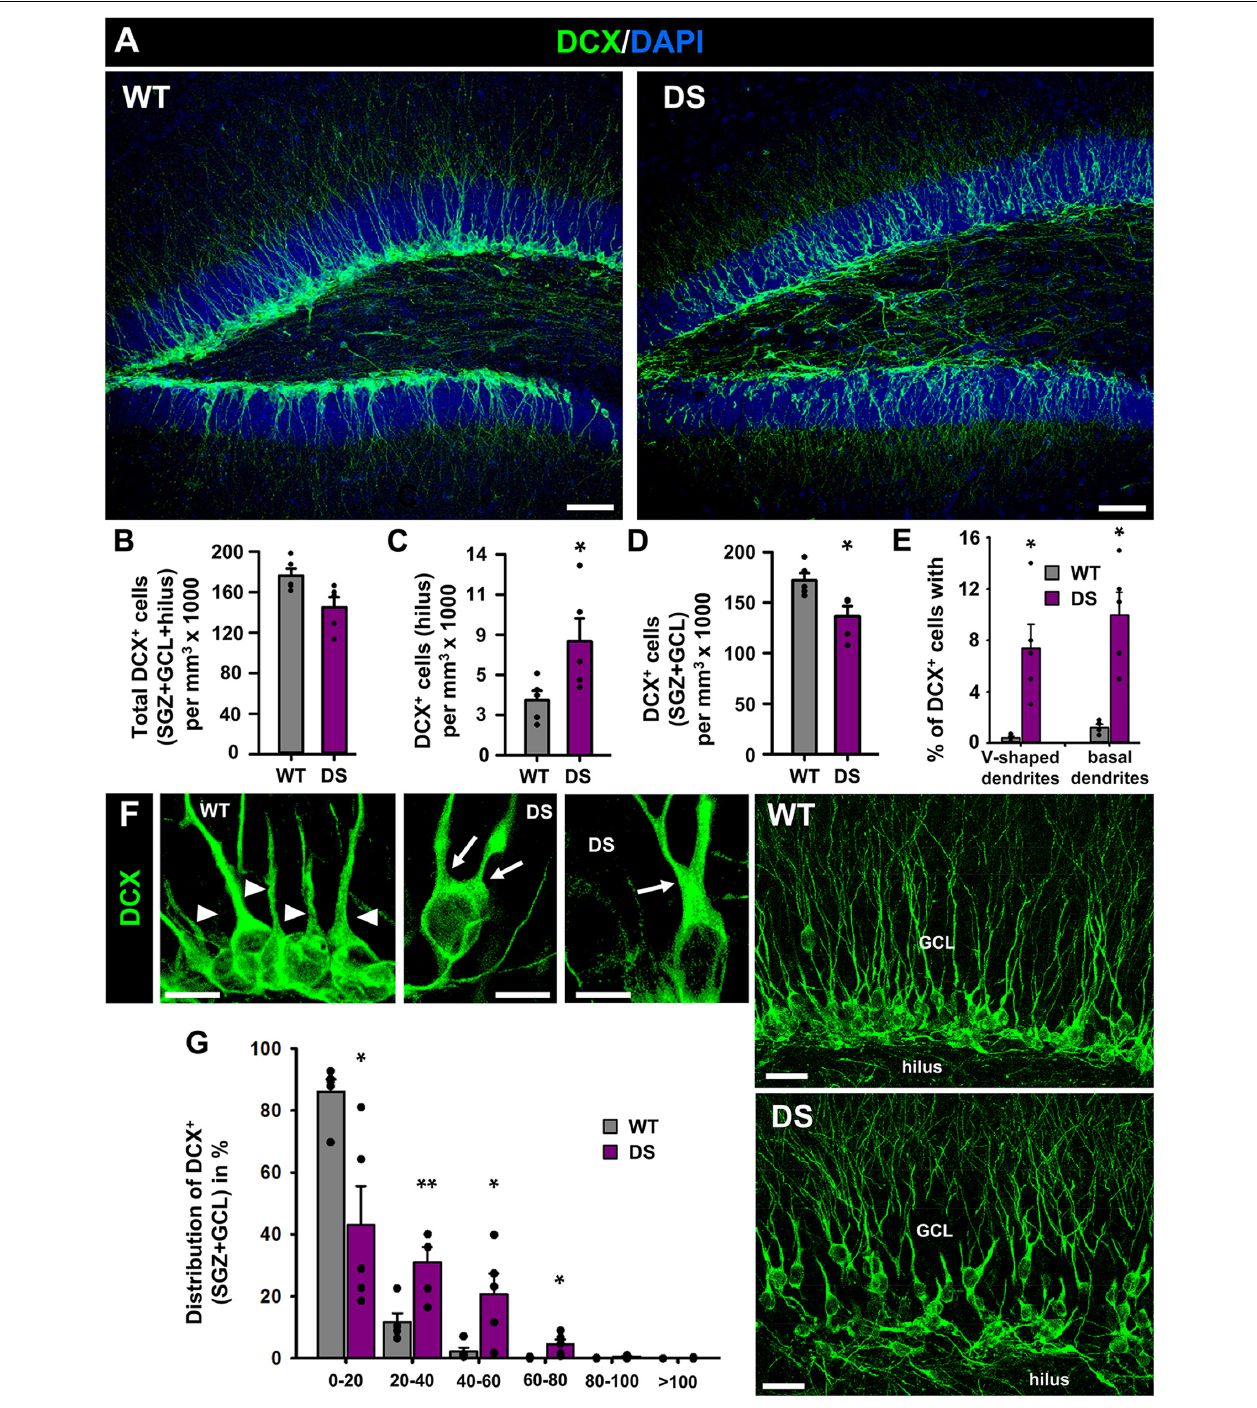
FIGURE 3 | Aberrant neurogenesis in DS mice. (A) Confocal-microscopy images of the DG of WT (left) and DS (right) immunostained for DCX (a specific marker of neuroblasts) and stained for DAPI. There are no differences in the overall number of DCX + -cells (B) but there are more neuroblasts in the hilus of DS mice (C) and correspondingly fewer in the SGZ+GCL (D) . In addition, neuroblasts in the DS mice presented with much higher frequency a V-shaped apical dendrite (two dendrites emerging directly from the soma or the main one bifurcating within the first 10 µ m) ( E , left) and basal dendrites ( E , right), as can be visualized in higher magnification images (F) . The arrowheads point toward single dendrites emerging from individual neuroblasts whereas arrows point toward two dendrites emerging directly from the soma or bifurcating in the most proximal segment. The images in the right show the abnormal migration of neuroblasts. In the DS mice, DCX + -cells had migrated to upper layers of the GCL, closer to the molecular layer whereas in the WT mice they are localized in the SGZ (G) . * p < 0.05, ** p < 0.01, by Student’s t -test. n = 5 for each condition. Bars show mean ± SEM. Dots show individual data. Scale bar in (A) is 40 µ m and 10 µ m in (F) (left) and 20 µ m in (E) (right).